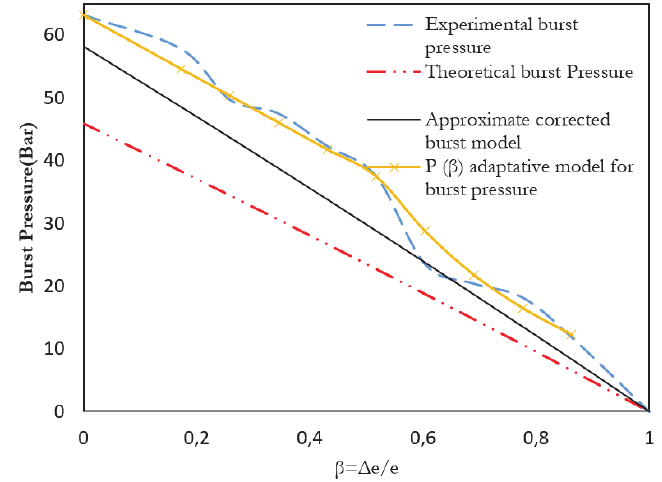
Figure 7: Theoretically corrected and adaptive estimation of burst